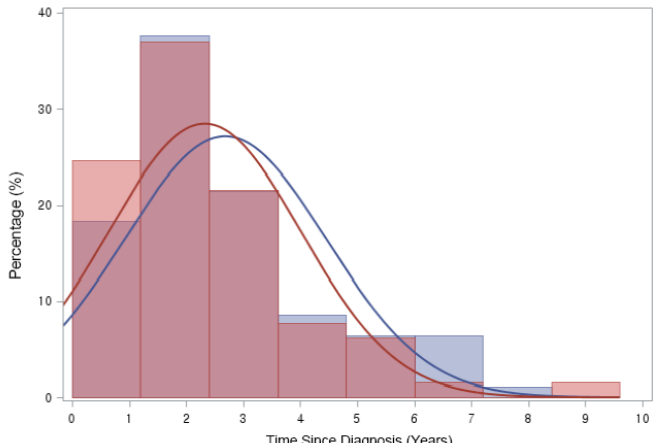
Figure 4. Time from ALL/LBL diagnosis to ON diagnosis. Time from cancer treatment to ON diagnosis was 2.54 ( ± 1.74) years after ALL or LBL diagnosis in all patients. Approximately 90% of patients were diagnosed as having ON in 5 years after primary cancer. (Blue line: Paediatric group (2.69 ± 1.77 years), Red line: Adult group (2.33 ± 1.68 years)). Table 2. Risk factors of